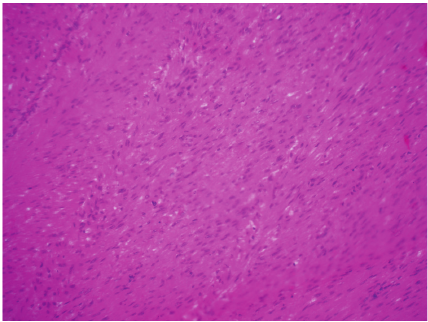
Figure 4: Photomicrograph depicting well-di ff erentiated multiple layers of hypercellular and hyperchromatic interwoven bundles of smooth muscle cells. H&E × 66.